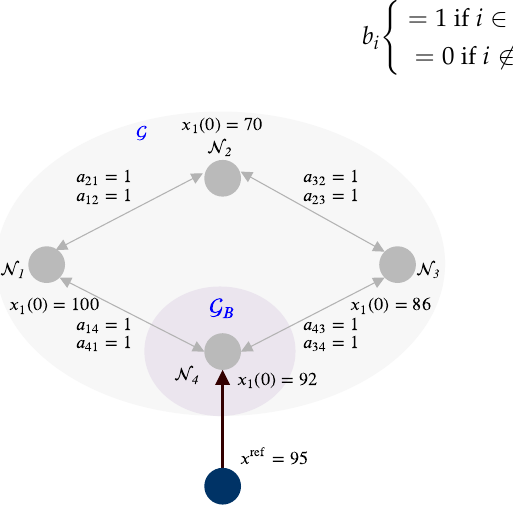
Figure 8. Graph related to the example in Figure